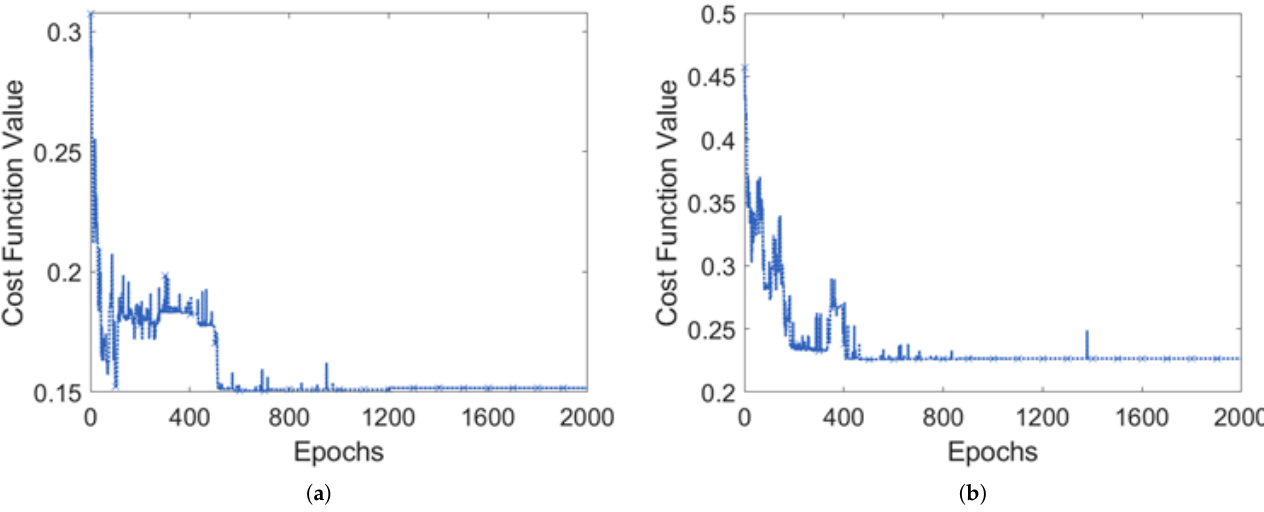
Figure 7. Number of BS = 240 and Random Seed = 8. ( a ) ES = 20. ( b ) ES =